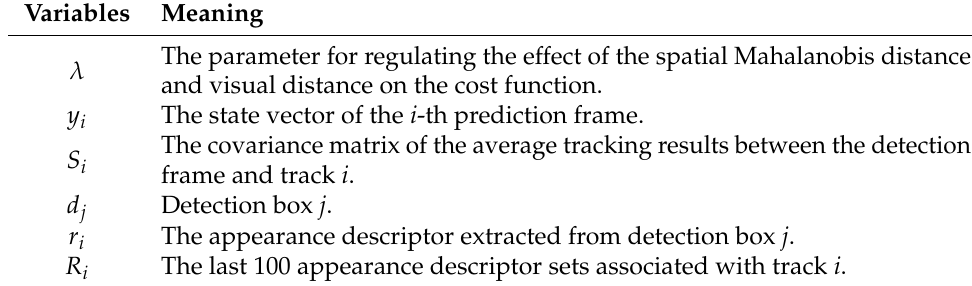
Table 1. Meanings of the